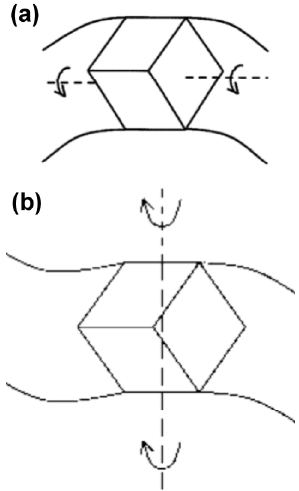
Figure 12. Schematic diagram of two rotation directions for catalysts during growth of ( a ) bidirectionally grown double helical carbon filament (b-DHCF) and ( b ) bidirectionally grown twisted carbon filament (b-TCF) [27]. Reprinted with permission from [27], Copyright 2003